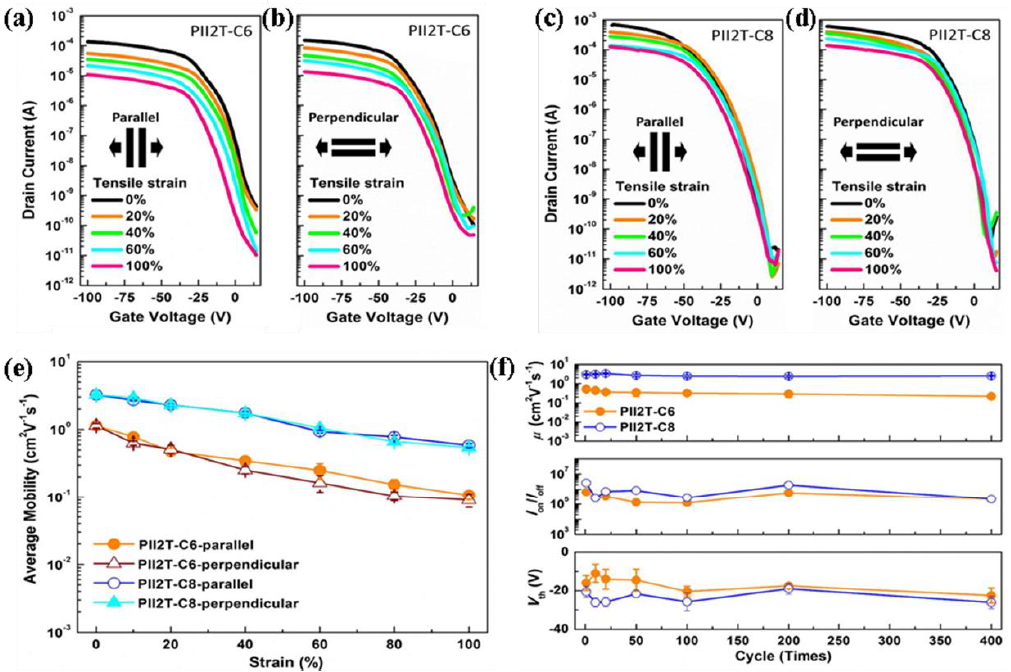
Figure 8. Transfer characteristic curves of polymer (PII2T-C6, PII2T-C8) films in parallel ( a , c ) and perpendicular ( b , d ) direction of charge transfer under different strains. ( e ) Field-effect mobility of polymer (PII2T-C6, PII2T-C8) films in horizontal and vertical directions under different strain levels. ( f ) Mobilities, on/off ratios, and threshold voltages of polymer (PII2T-C6, PII2T-C8) films during 400 tensile/release cycles at 60% strain.